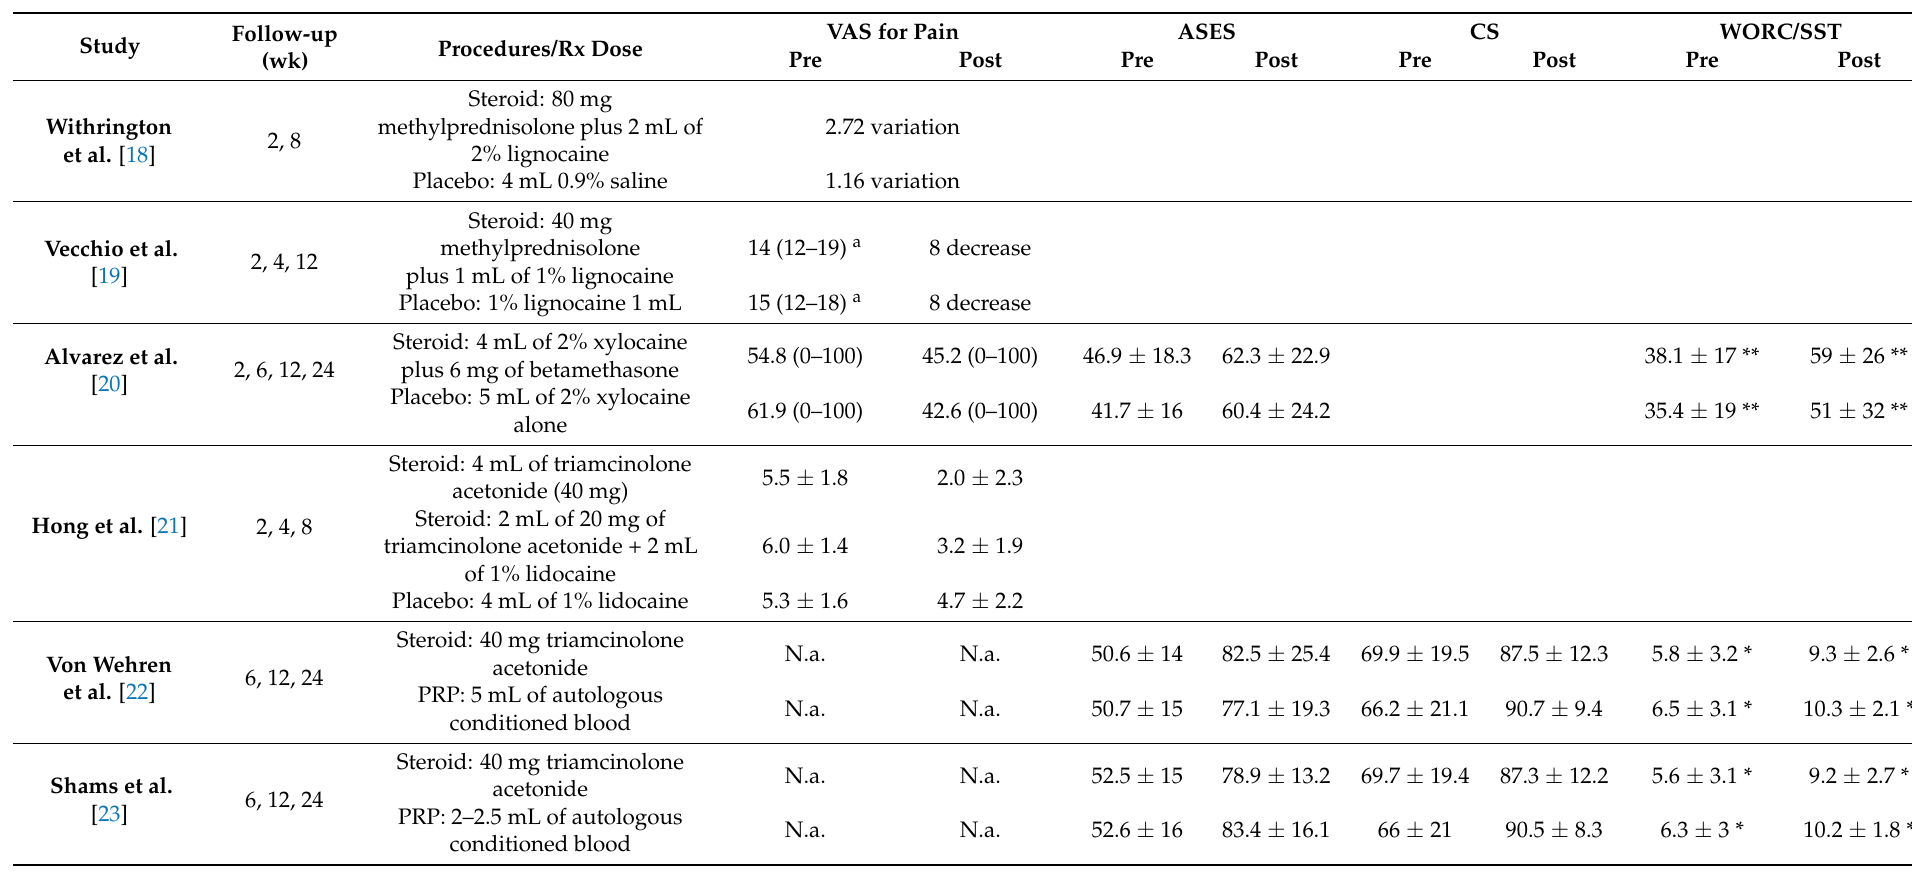
Table 3. Summary: pain-function scores. N.a., not available, data reported by the article do not permit the evaluation of the parameter; a sum of visual analogue scores for pain at rest, movement and night; † scored on a five-point Likert scale (very bad, bad, poor, fair, good) and converted to a numerical score from 0 to 4 (not VAS); †† CSS ( Constant Shoulder Score) scores: <11 is excellent, 11–20 is good, 21–30 is fair and >30 is poor; * SST; ** WORC. Abbreviations: ASES, American Shoulder and Elbow Surgeons Shoulder Score; CS, Constant Shoulder Score; WORC, Western Ontario Rotator Cuff Index; SST, Simple Shoulder Test; Pre: preoperative; Post: postoperative at last